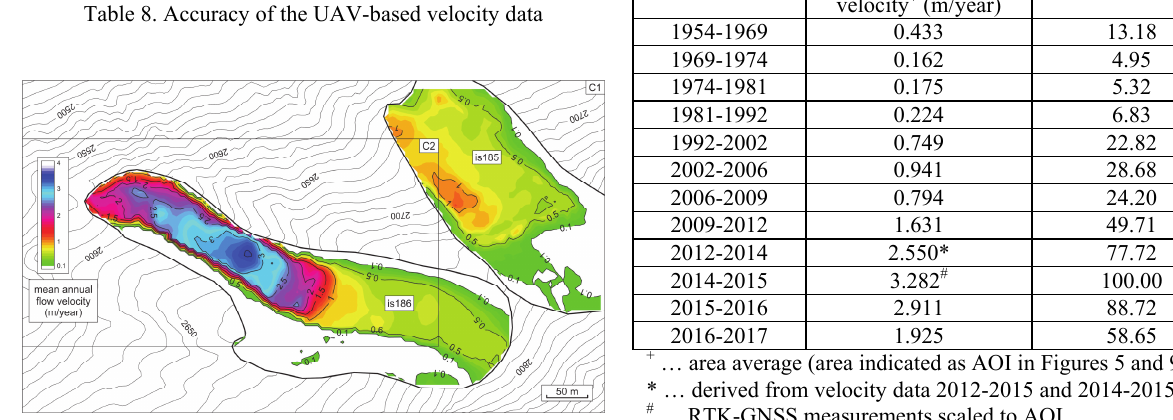
Table 8. Accuracy of the UAV-based velocity data